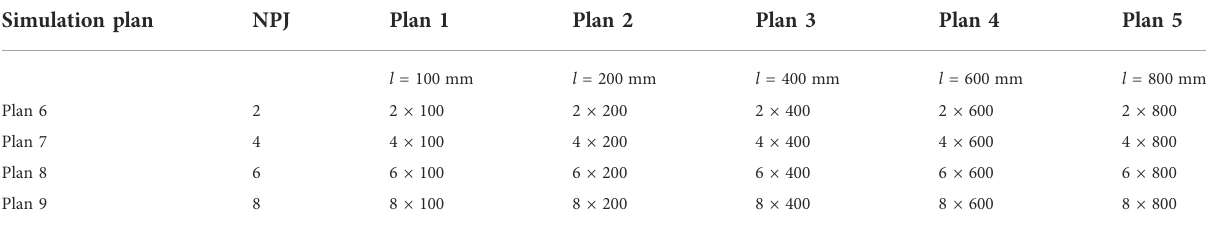
where l is the rock size.